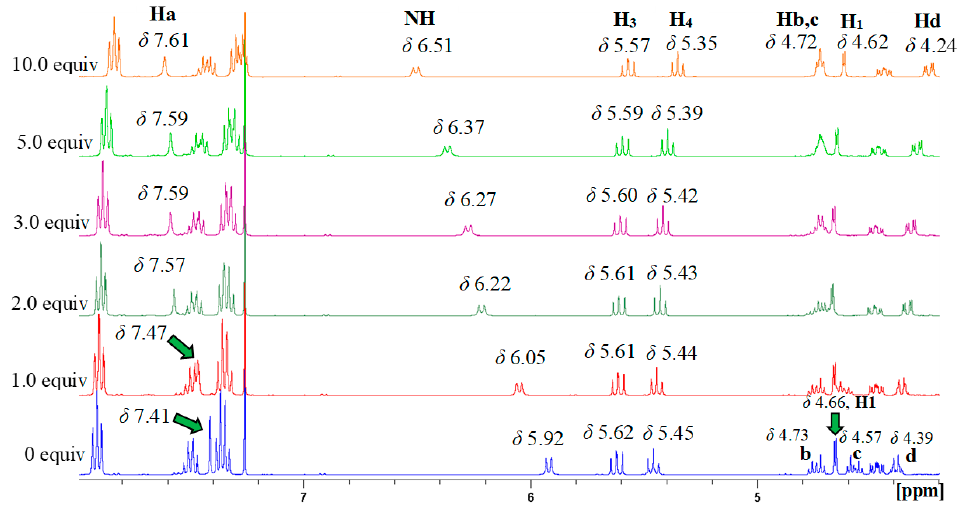
Figure 3. 1 H NMR spectra of LM28 with different amounts of TBACl from 0 to 10.0